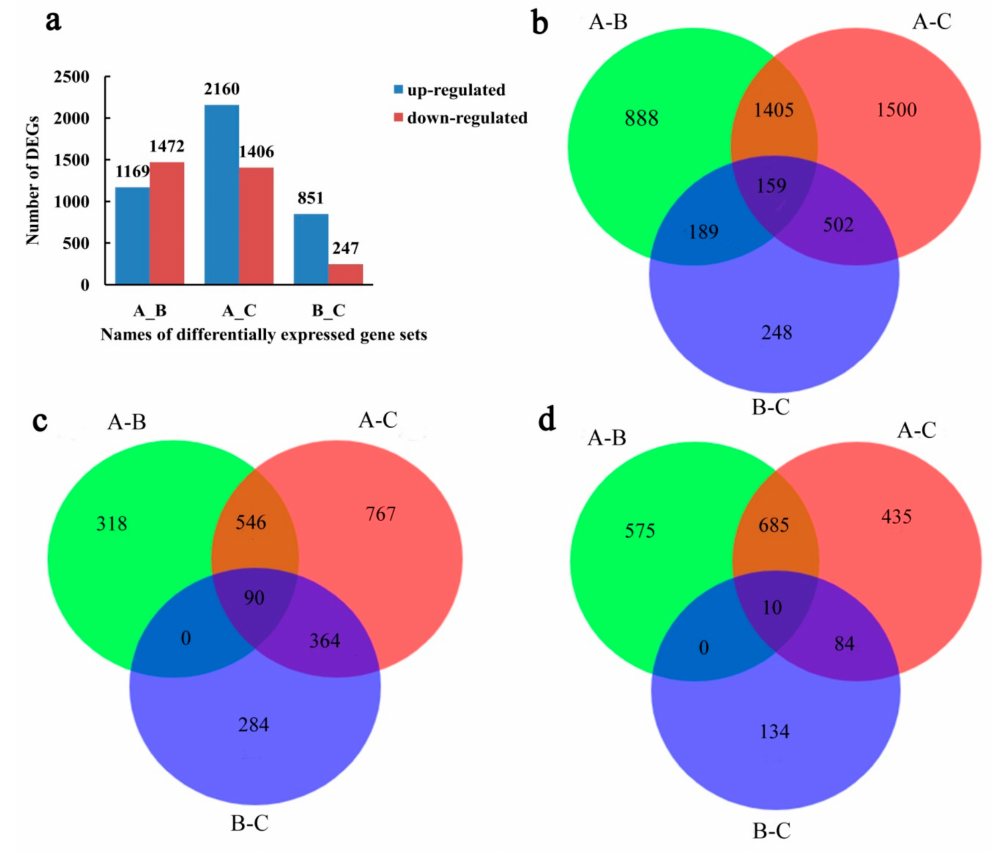
Figure 3. The graphical representation of di ff erentially expressed genes (DEGs) of Camellia oleifera ‘Huaxin’ in response to low-temperature stress. ( a ) Number of up / down-regulated DEGs in the A_B, A_C, and B_C di ff erential expression gene sets; ( b ) Venn diagram showing all DEGs numbers among the three gene sets; ( c ) Venn diagram showing up-regulated genes DEGs numbers among the three gene sets; ( d ) Venn diagram showing down-regulated DEGs numbers among the three gene